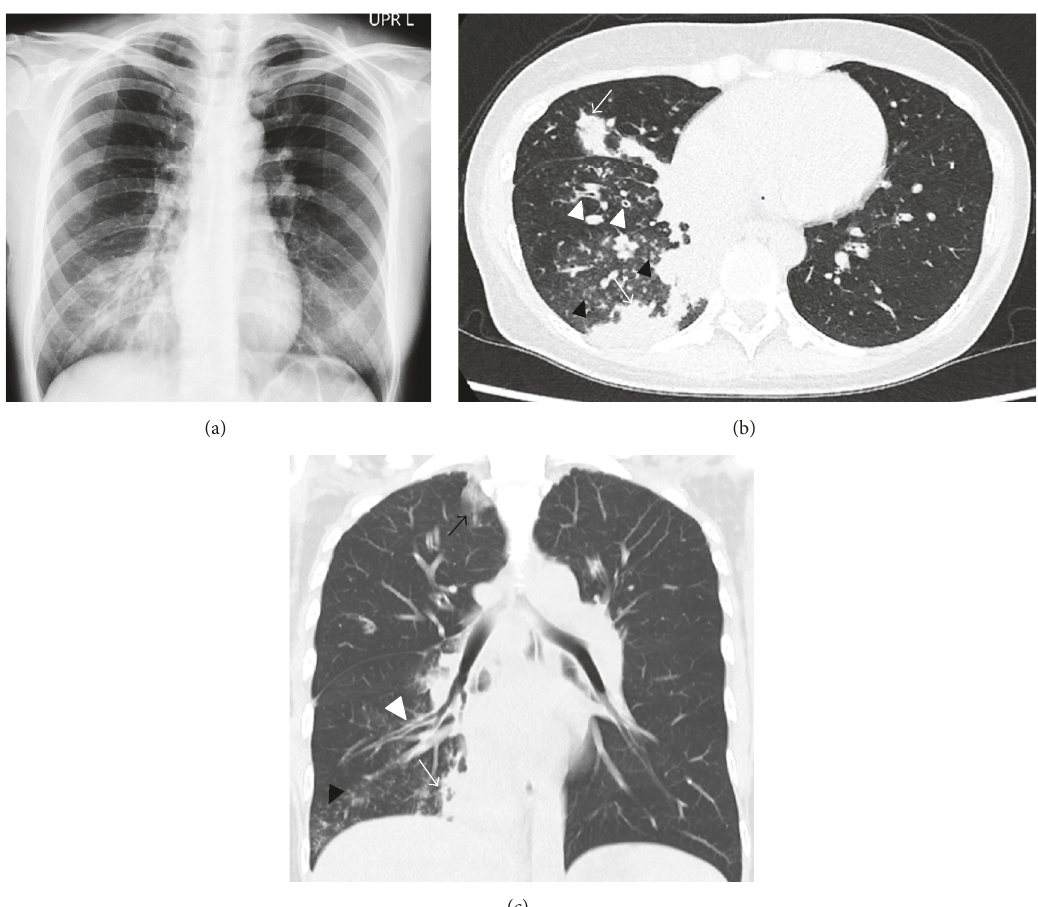
Figure 1: Chest radiography (a), axial view (b), and coronal view (c) of chest computed tomography (CT) images of the case. The chest X-ray showed a high-density area in right lower lobe. The chest CT revealed airspace consolidations (white arrows), thickening of bronchial walls (white triangles), and numerous centrilobular nodules (black triangles). The coronal view showed ground-glass opacity in the right upper lobe (black